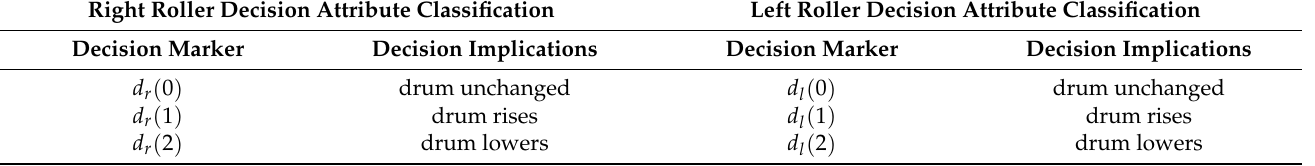
Table 2. Feature decision meaning